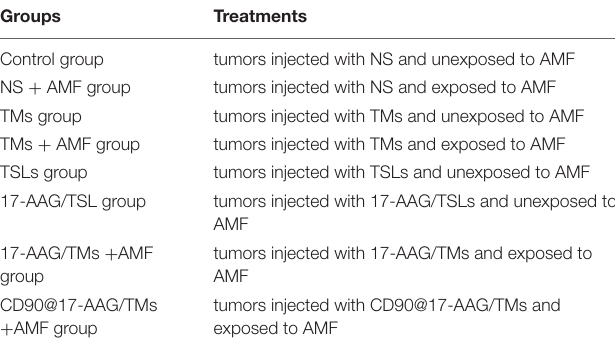
TABLE 1 | Groups and treatments of targeted therapy of